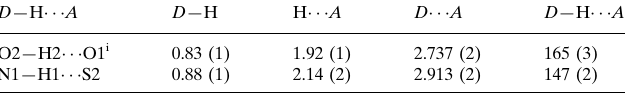
Hydrogen-bond geometry (A˚ , (cid:2)